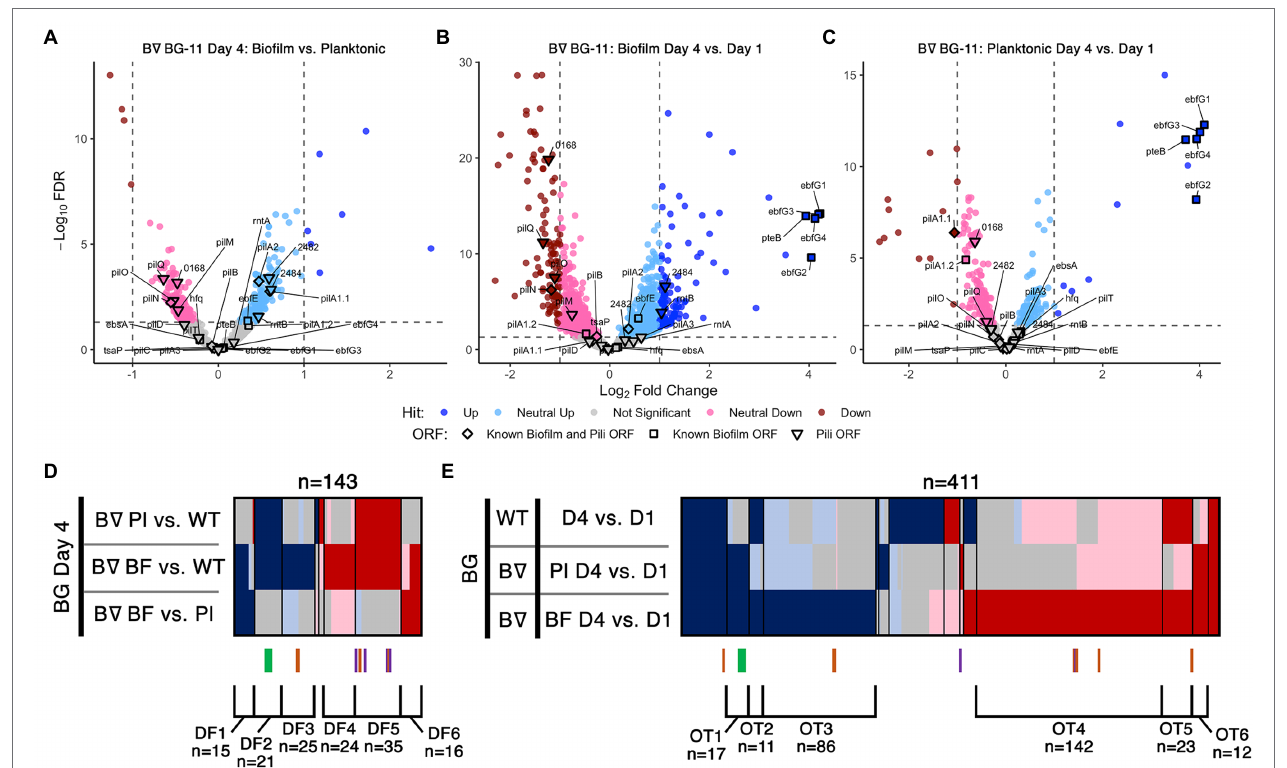
FIGURE 2 | Day 4 and time course RNA-Seq analysis. Volcano plots, presented as described for Figures 1B,C , of (A) Day 4 pairwise comparison of PilB ::Tn 5 biofilms vs. planktonic cells, (B) PilB ::Tn 5 biofilms on Day 4 vs. PilB ::Tn 5 on Day 1, and (C) PilB ::Tn 5 planktonic cells on Day 4 vs. PilB ::Tn 5 on Day 1. Comparison of sDEGs associated with (D) Day 4 and (E) over time are presented as described for Figure 1D